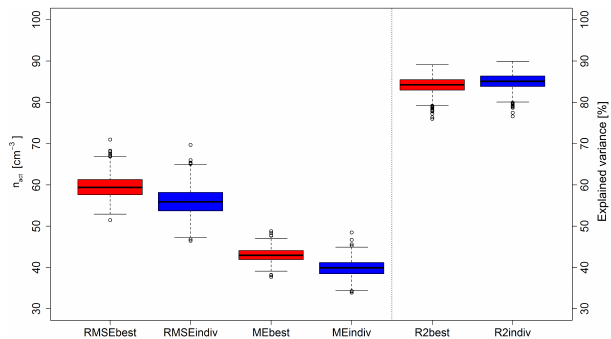
Figure 13. A box plot of the R 2 , RMSE and ME values for the application of the general model (Eq. 5) to 1000 random samples of 100 data points from each year. The red boxes show the range of R 2 and error values when Eq. (5) is applied to the sampled data, while the blue boxes show the ranges when the model is refitted individually to the data sampled in each case.